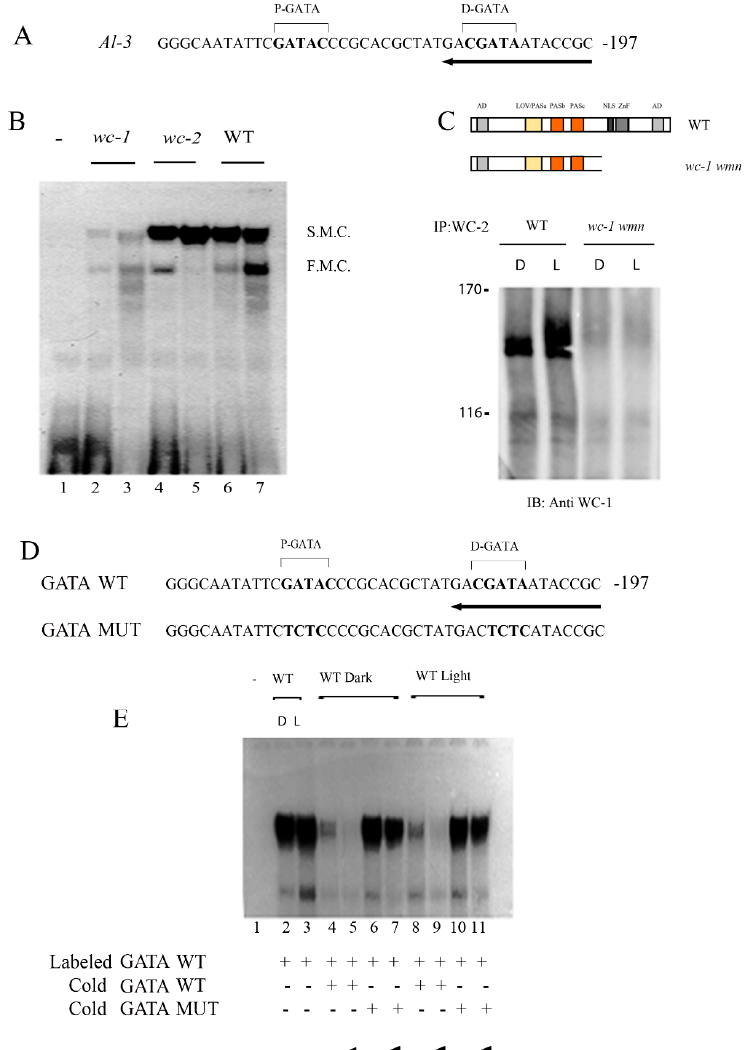
Figure 1. Dark/Light binding of WHITE COLLAR Complex (WCC) to the light-responsive elements (LREs) of al-3 . ( A ) The DNA sequence of LRE in the promoter of al-3 used as a radioactive probe for the Electrophoresis Mobility Shift Assay (EMSA) assay. The sequence was based on previously published data [26]. The arrow indicates the direction towards the transcriptional start site. ( B ) EMSA assay was performed incubating a double-stranded oligonucleotide probe containing the LREs of al-3 promoter and a nuclear extract from Neurospora crassa . Lane 1 does not contain extract. In lanes 2–3 the probe was incubated with the nuclear extract obtained from wc-1 null mutants grown either in the dark (lane 2) or light-treated for 20 min (lane 3). Same conditions were used in lanes 4–5 ( wc-2 mutant, 234 w) and 6–7 (wt). ( C ) Interaction of WC proteins is dependent on WC-1 C-Term region. WC-2 protein was immunoprecipitated with an anti-WC-2 antiserum from wt or wmn [23] (grown in the dark or 20 min after the light pulse. The immunoprecipitated complexes were resuspended in Laemmli buffer and loaded on SDS-PAGE. Western blot was performed using an anti-WC-1 affinity purified antibody. ( D ) DNA sequence used as cold probes for the EMSA competitive assay ( D ) based on ( A ). The upper sequence is a wt LRE region of the al-3 promoter. In the lower sequence, the GATA is mutagenized. ( E ) EMSA assay was performed by incubating the labelled double-stranded oligonucleotide with no nuclear extract (lane1), an equal amount of nuclear extract (10 µ g) derived from dark growth mycelia (lane 2), or mycelia induced to light for 20 min. (lane 3). The specificity of the binding was verified by co-incubating the labelled oligonucleotide and nuclear extracts obtained from dark growth mycelia or light-treated for 20 min as following. Samples were incubated in the presence of a 10- or 50-fold excess of cold-specific competitor (lanes 4–5, 8–9), or 10- or 50-fold excess of unlabeled specific competitor harboring mutations in both the GATA motifs (lanes 6–7,